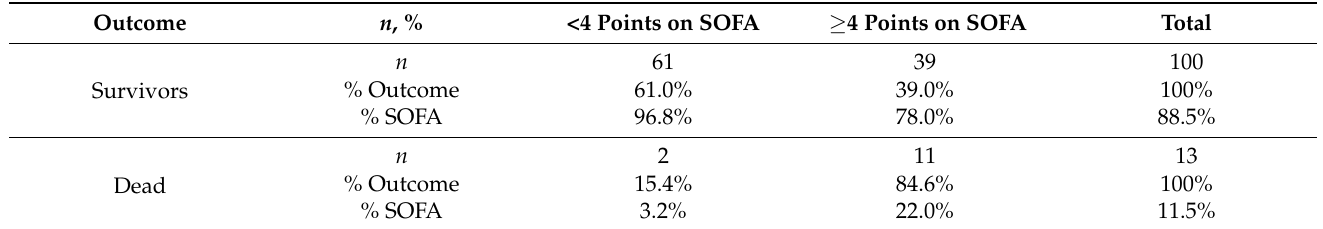
Table 2. Comparison of hospital outcome and severity at admission of patients with obstructive jaundice ( p = 0.002; Pearson’s X 2 ).